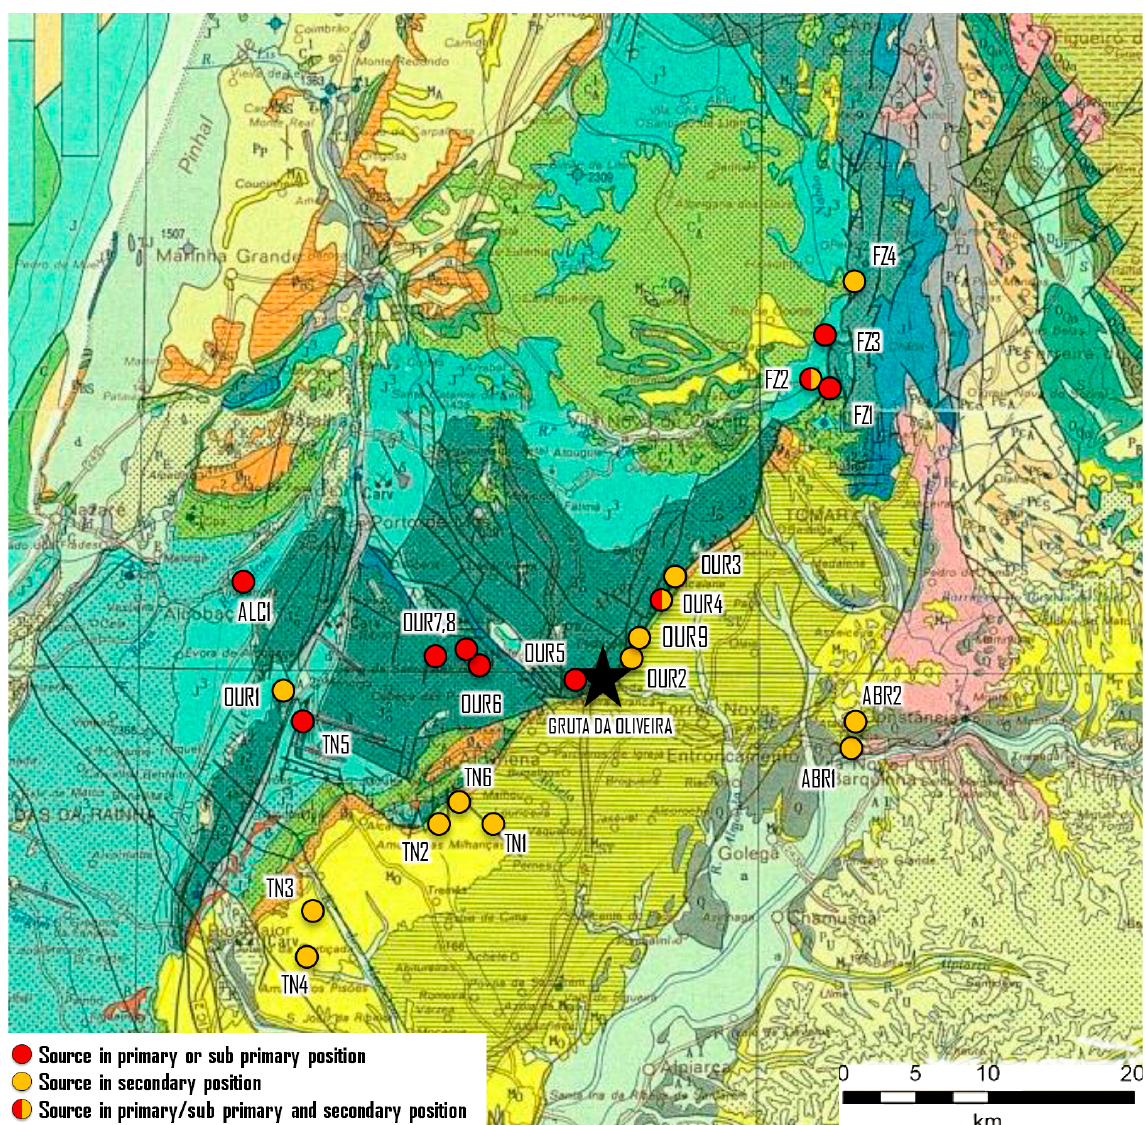
Figure 2. Detail of the Geological Map of Portugal (1:500.000, resized) (Delfim de Carvalho et al. 1992), showing the Central Limestone Massif and surrounding area of the Tagus Sedimentary Basin, with location of the geological samples used in this